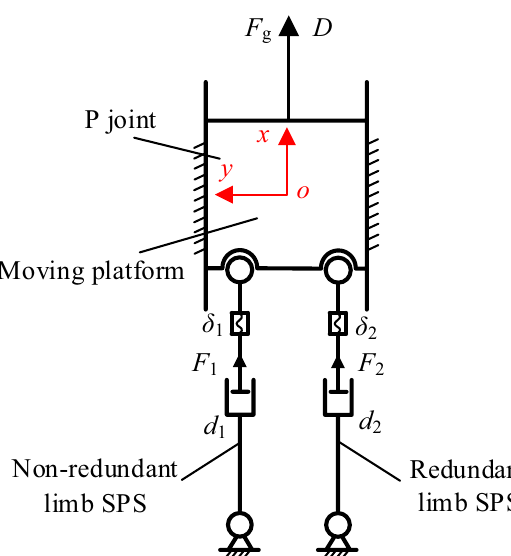
Figure 4 The 2SPS P active overconstrained +